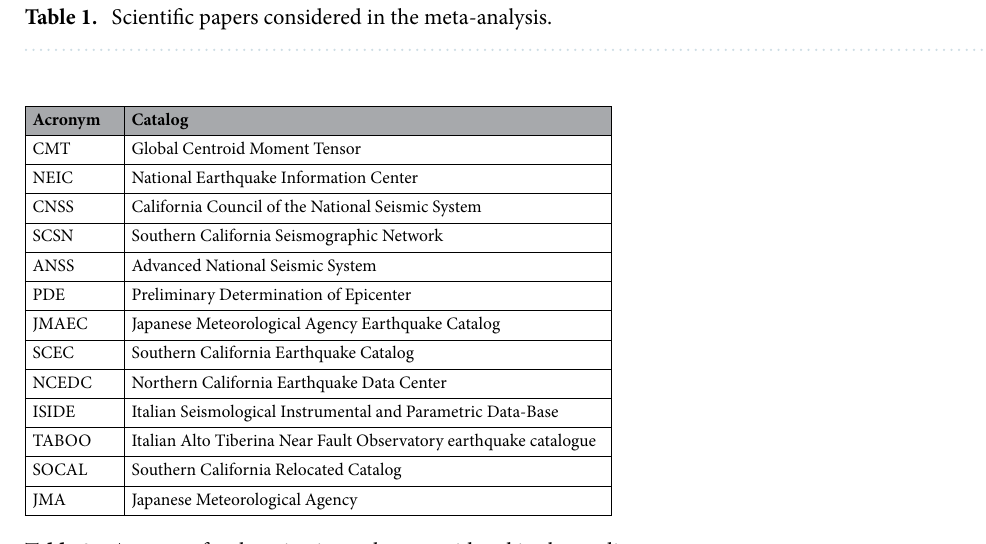
Table 2. Acronym for the seismic catalogs considered in the